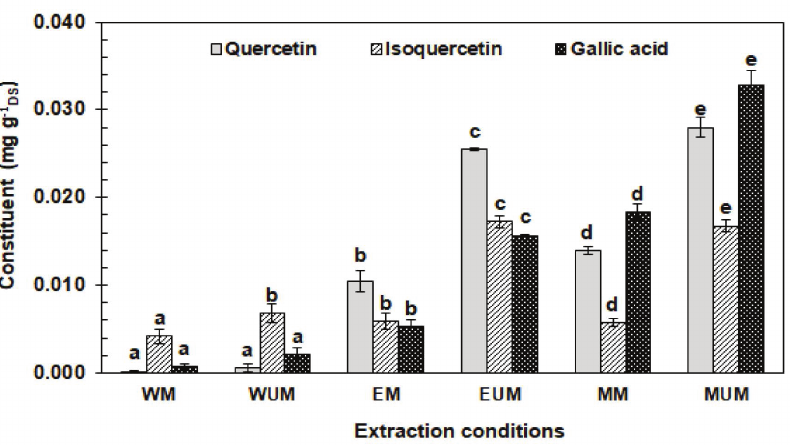
Fig. 4 – Quercetin, isoquercetin, and gallic acid contents in the crude extract of BTP fermented (no nitrogen supplementation) by water, ethanol, and methanol during maceration (WM, EM, MM) and ultrasound-maceration extractions (WUM, EUM, MUM) for 5